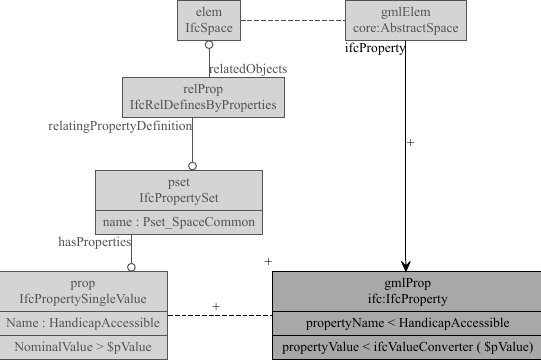
Figure 11. A rule that extracts the handicapAccessible property from IfcSpace and sets it as a new IfcProperty node in